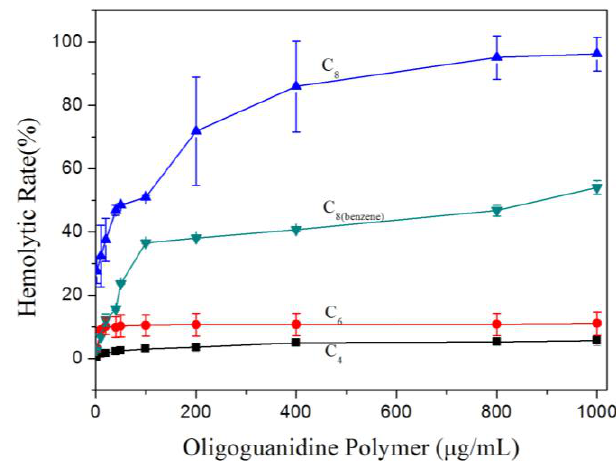
Figure 3. Hemolytic property of synthesized oligoguanidine Polymer C 4 , C 6 , C 8 , C 8(benzene) against human erythrocytes. Fresh human erythrocytes were obtained by centrifuging the whole blood at 3000 revolutions per minute (rpm) for 10 min. Hemolysis was monitored by measuring the absorbance of hemoglobin released due to cell lysis at 414 nm.